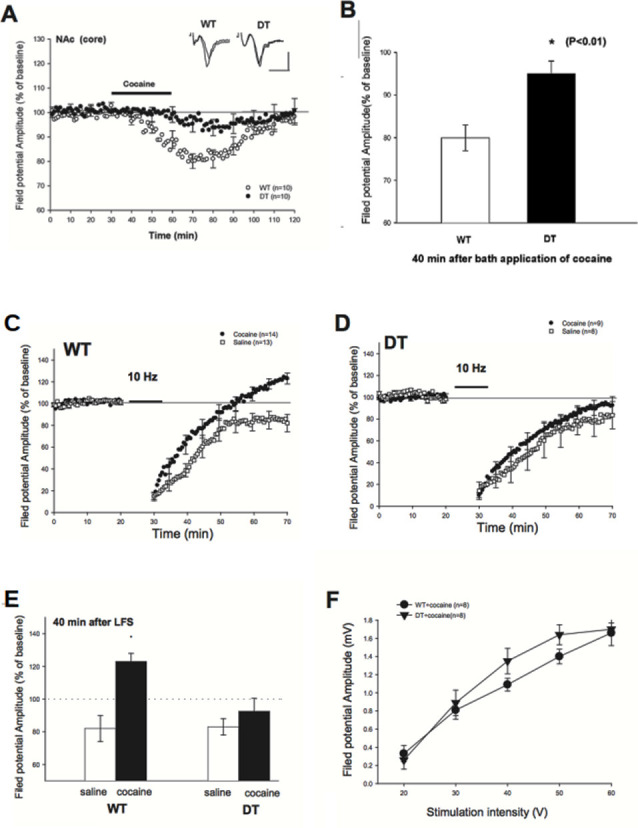
Reduced depression of field potential at baseline and Long-Term Synaptic Depression (LTD) blockade impairment in cocaine-treated DN-CPEB mice. (A) Brain slices from WT and DN-CPEB were used to record the extracellular field potential from the core of NAc in the presence or not of cocaine (30 μM), directly applied to the bath perfusion. (B) Quantification of the field potential amplitude at 40 min after cocaine application. DN-CPEB mice have a significantly different response compared to WT (p < 0.01). WT (C,D) DN CPEB mice (DT = double transgenic) slices were used to assess LTD in the excitatory synaptic transmission of NAc elicited by low frequency (10 Hz) stimulation. (E) Graphical representation of the quantification of the responses recorded in (C,D). (F) Input/output curve of WT and DN-CPEB mice following cocaine administration as a function of increased stimulation intensity. *p < 0.05.